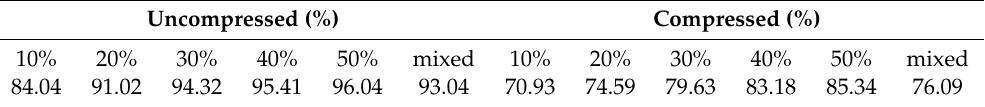
Table 4. The average detection accuracies of our proposed approach without preprocessing.